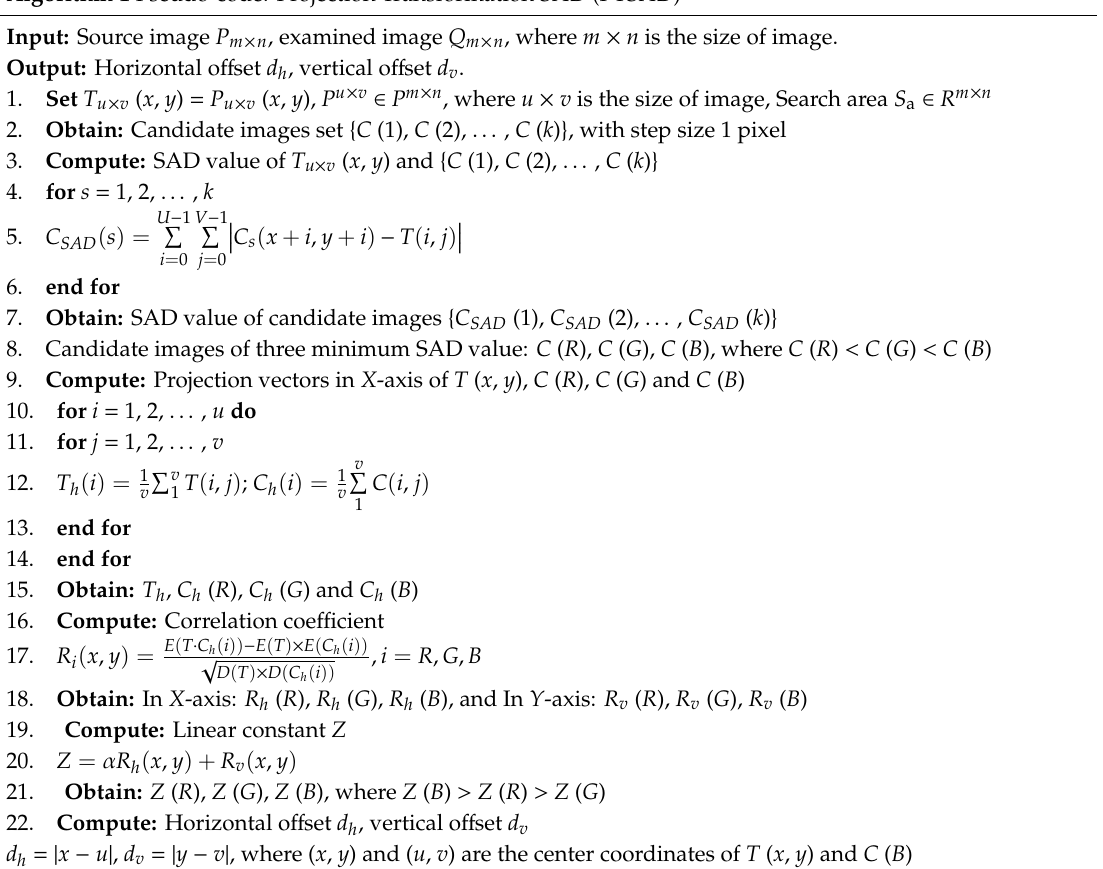
Algorithm 1 Pseudo-code: Projection Transformation SAD